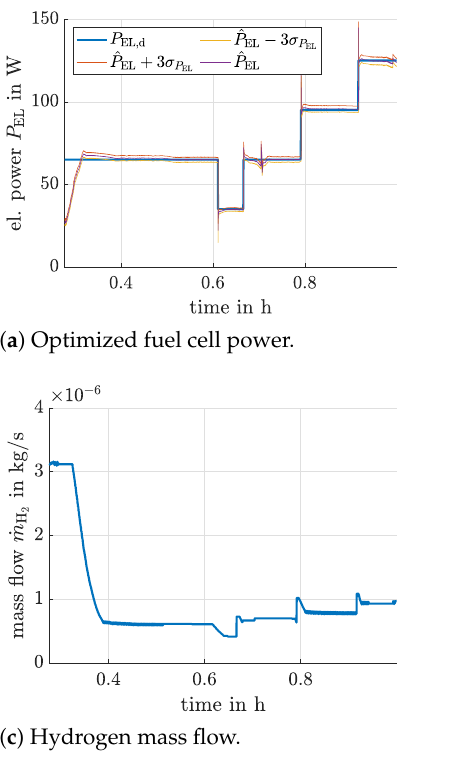
Figure 13. Input optimization for the fractional-order system model with n = 3 for step-wise changes of the desired electric power.